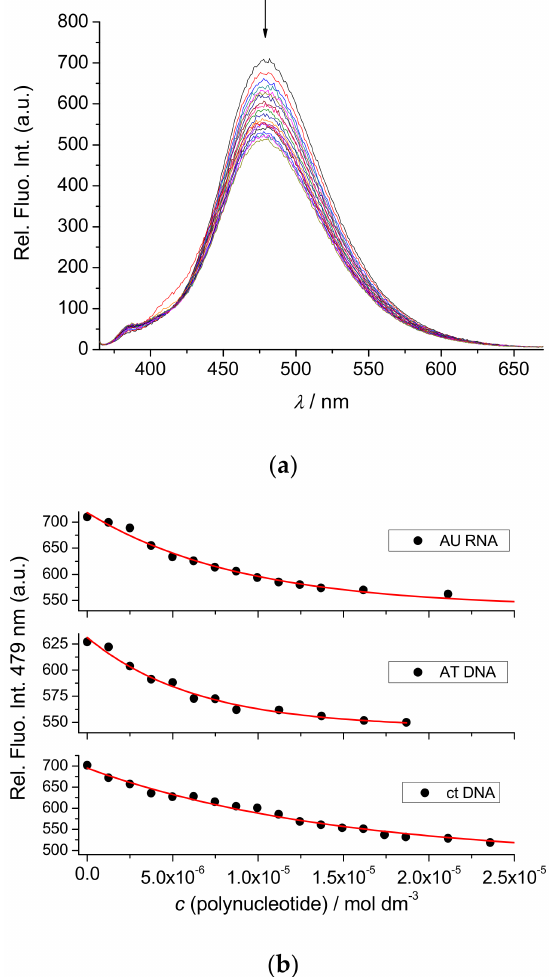
Figure 10. ( a ) Changes in fluorescence spectrum of DAE-NH-Py open ( c = 1.0 × 10 − 6 M) upon titration with ct-DNA; ( b ) Dependence of emission intensity at λ max = 479 nm on c(polynucleotide), data fitted to Scatchard Equation [42] ( – ). Done at pH = 7.0, buffer sodium cacodylate, I = 0.05 M, 0.04 %